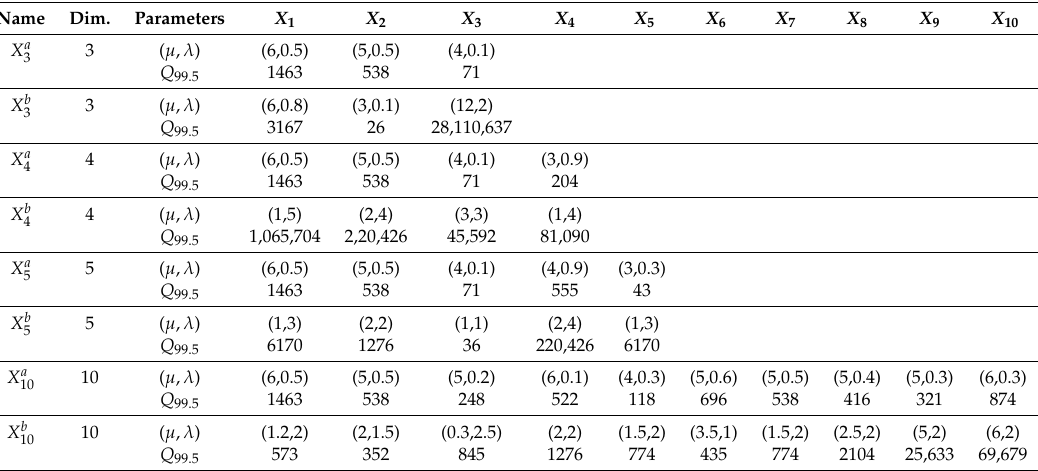
Table 7. Marginals for each risk factor and corresponding 99.5th